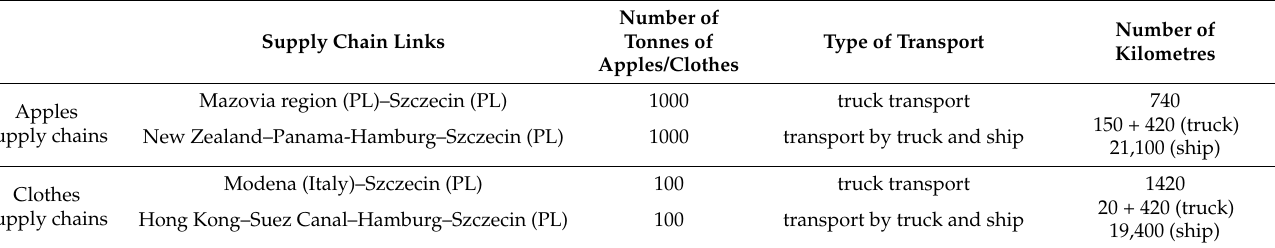
Table 3. Input data to the simulation